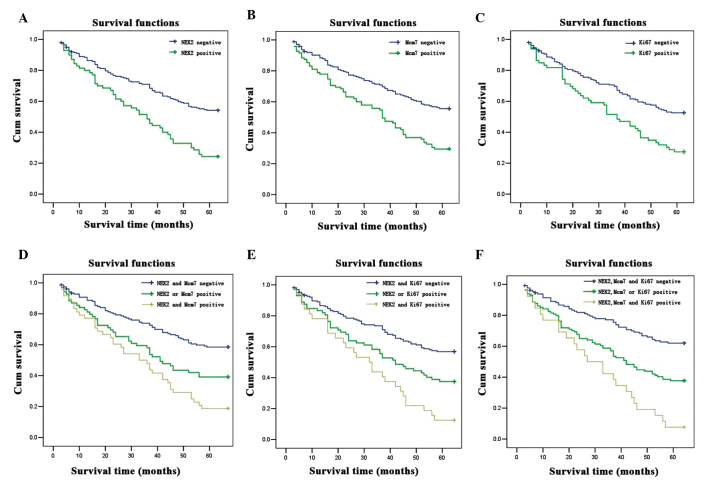
Kaplan-Meier curves of overall survival in NSCLC patients. (A) The 5-year overall survival rates were 55.0 and 24.3% in the patients with NSCLC with NEK2-negative expression (n=200) and NEK2-positive expression (n=70). (B) The 5-year overall survival rates were 56.6 and 29.5% in the patients with NSCLC with Mcm7-negative expression (n=175) and Mcm7-positive expression (n=95). (C) The 5-year overall survival rates were 53.4 and 27.3% in the patients with NSCLC with Ki67-negative expression (n=204) and Ki67-positive expression (n=66). (D) The 5-year overall survival rates were 59.5, 39.1 and 18.8% in the patients with NSCLC with NEK2- and Mcm7-negative expression (n=153), NEK2- or Mcm7-positive expression (n=69), and NEK2- and Mcm7-positive expression (n=48). (E) The 5-year overall survival rates were 57.8, 37.5 and 12.5% in the patients with NSCLC with NEK2- and Ki67-negative expression (n=166), NEK2- or Ki67-positive expression (n=72), and NEK2- and Mcm7-positive expression (n=32). (F) The 5-year overall survival rates were 63.1, 37.7 and 7.7% in the patients with NSCLC with NEK2-, Mcm7- and Ki67-negative expression (n=130), NEK2-, Mcm7- or Ki67-positive expression (n=114) and NEK2-, Mcm7- and Ki67-positive expression (n=26). There were significant differences between NEK2- and Mcm7/Ki67-positive, NEK2- or Mcm7/Ki67-positive, and NEK2- and Mcm7/Ki67-negative expression groups (P<0.0001).